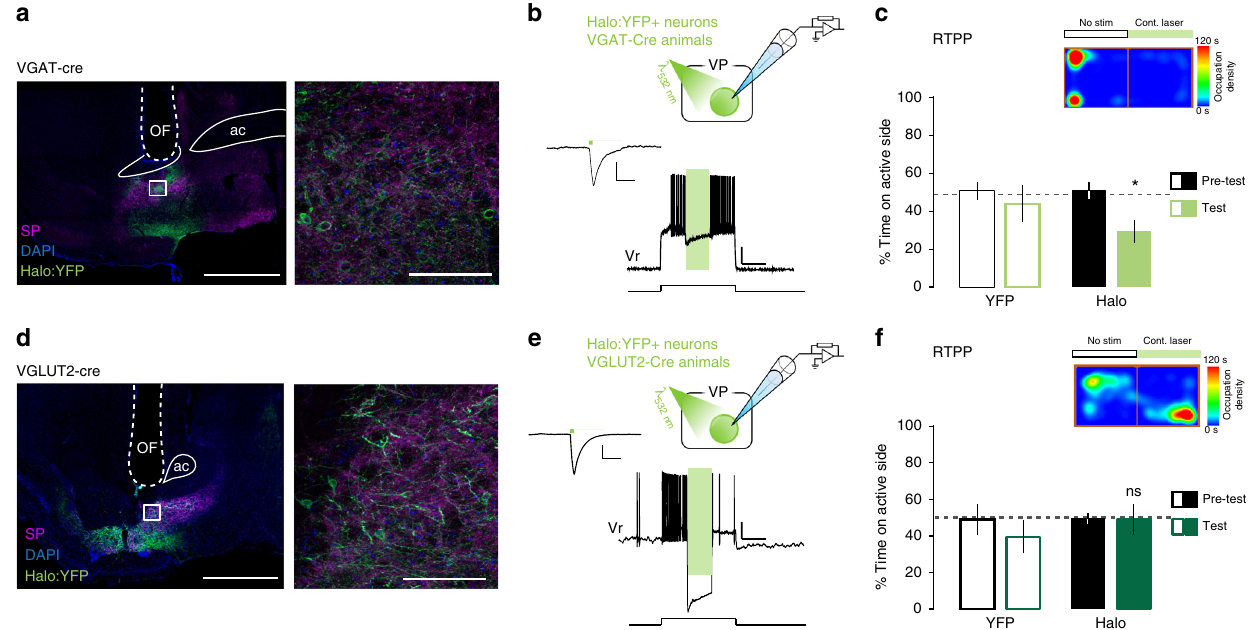
Fig. 5 Inhibition of VP GABA but not glutamate neurons induce place avoidance. a Expression of Halo:YFP (green) in VP GABA neurons. Counterstaining with SP (purple) and DAPI (blue); OF optic fi ber track; ac anterior commissure. b 1-s light pulse inhibits fi ring of VP GABA neuron; scale = 20 mV, 1 s. Inset shows photocurrent from Halo:YFP-expressing VP GABA neuron in response to 5-ms pulse of green light; scale = 4 pA, 50 ms. c Mice avoid the compartment paired with bilateral inhibition of VP GABA neurons in the RTPP ( n = 5 YFP, n = 6 Halo). d Expression of Halo:YFP (green) in VP glutamate neurons. e 1-s light pulse inhibits fi ring of VP glutamate neuron; scale = 20 mV, 1 s. Inset shows hyperpolarizing photocurrent from Halo:YFP-expressing VP glutamate neuron in response to 5-ms pulse of light; scale = 20 pA, 50 ms. f Bilateral inhibition of VGLUT2 + VP cells did not induce preference or avoidance in the RTPP ( n = 5 YFP, n = 8 Halo). Image scale bars = 500 µ m (left panels) and 100 µ m (right panels); * p <